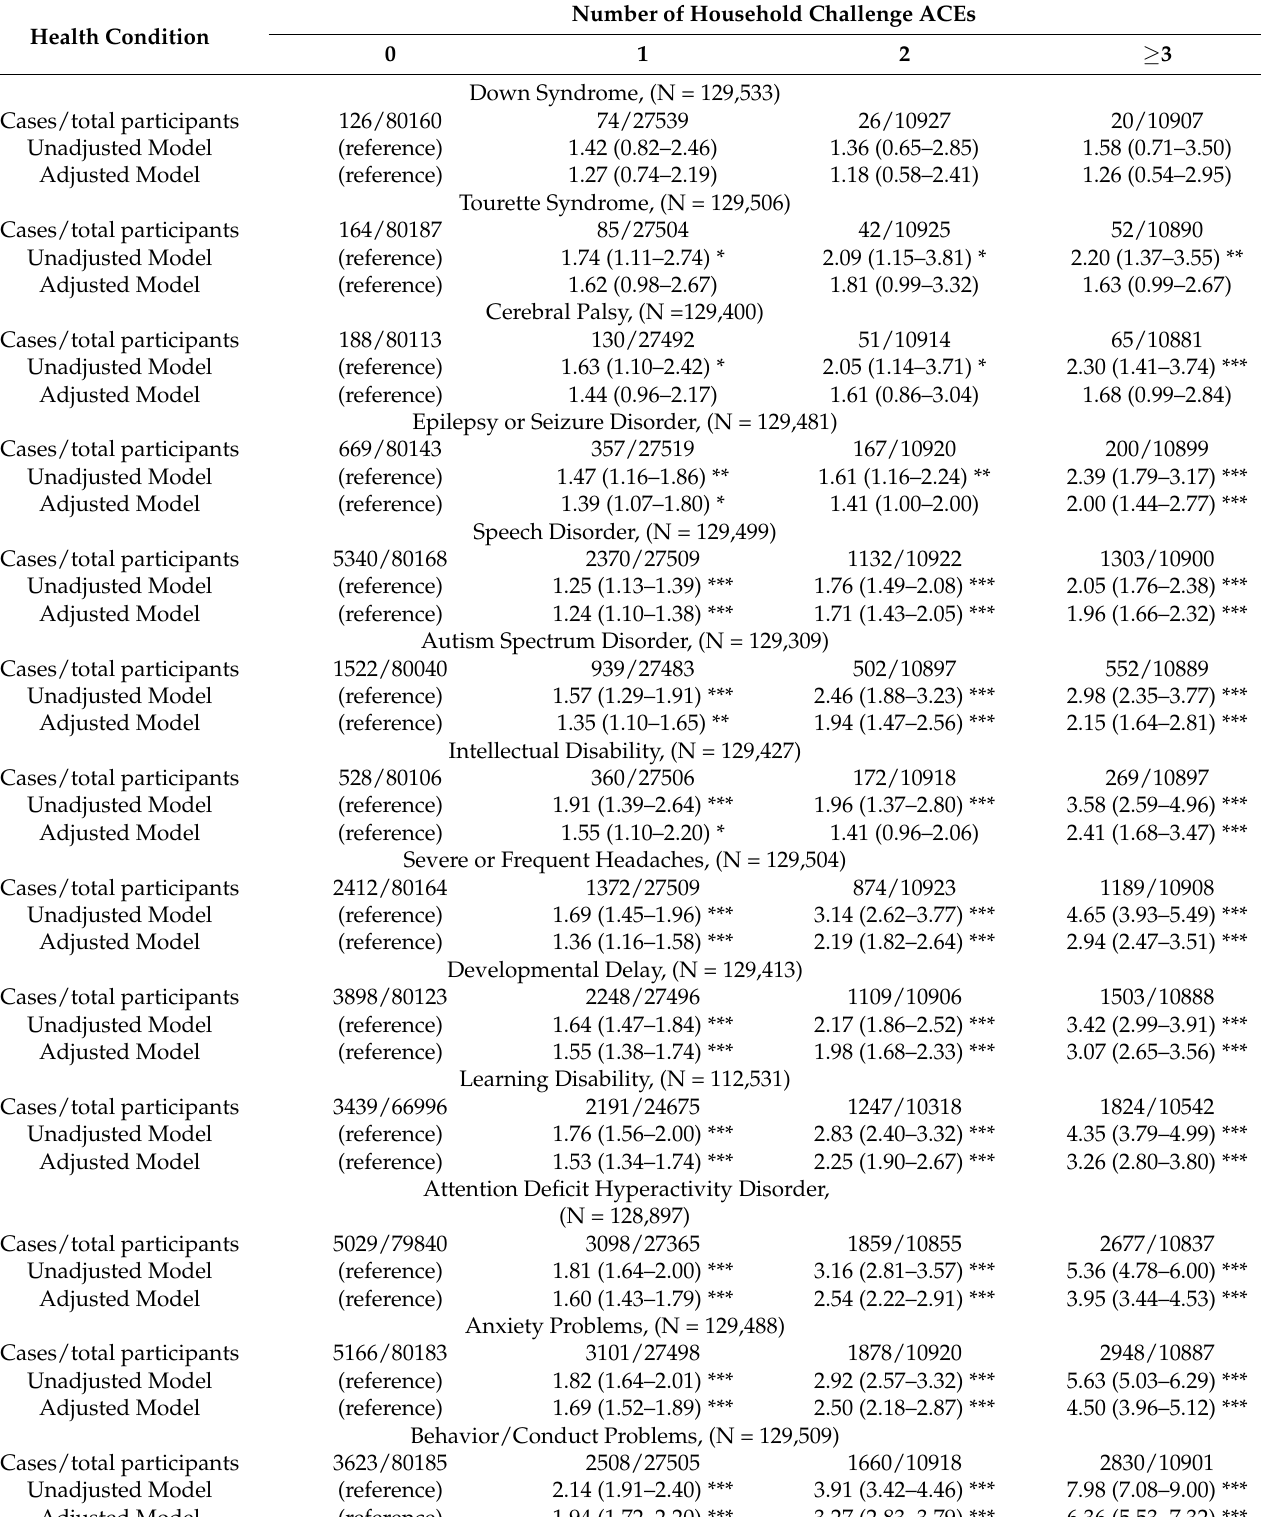
Table 3. Odds ratio (95% CI) of health condition as a function of the number of